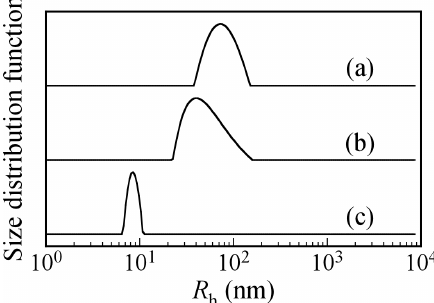
Figure 8. Hydrodynamic radius ( R h ) distributions for ( a ) PICsomes at f + = 0.5, and PIC aggregates ( b ) at f + = 0.4 and ( c ) f + = 0.2 formed by addition of P 20 A 196 solution to PICsomes with f + = 0.5 in 0.1 M aqueous NaCl solutions at C p = 0.5 g/L.